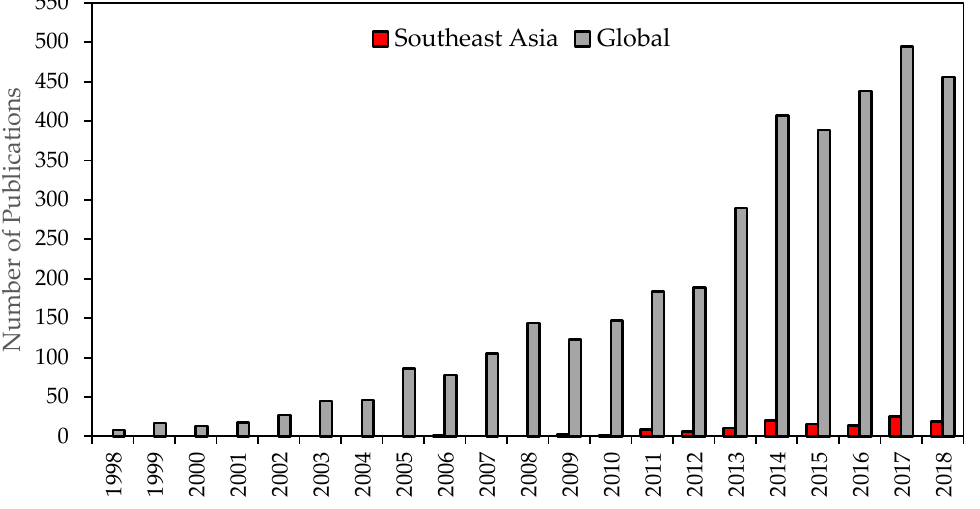
Figure 2. SWAT publications for entire globe and for Southeast Asia.